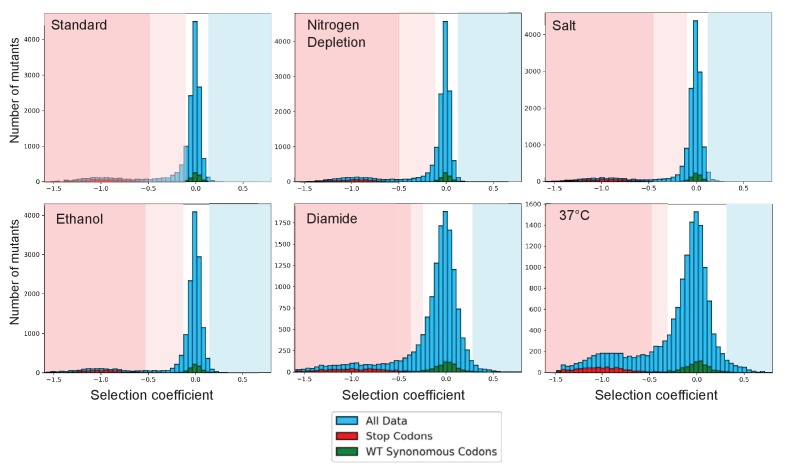
Distribution of selection coefficients in each environmental condition.Mutations were categorized as beneficial (light blue shading), wild-type-like (white shading), intermediate (light pink shading) or deleterious (dark pink shading) based on the distribution of wild-type synonyms and stop codons in each condition.